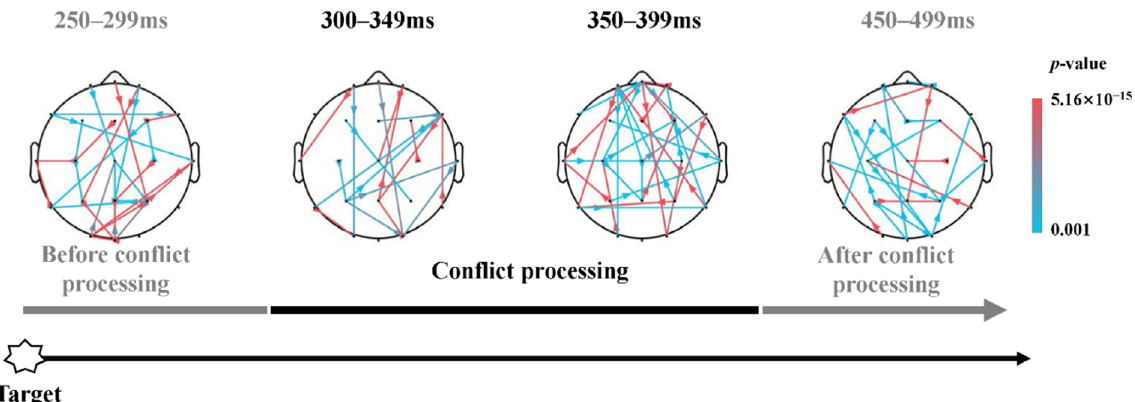
Figure 10. Dynamic information flow corresponding to the executive network within 3 distinct sub- stages after the onset of target. Stronger information flow induced by incongruent target compared to congruent target ( t (38) = 3.585, p < 0.01, FDR corrected).